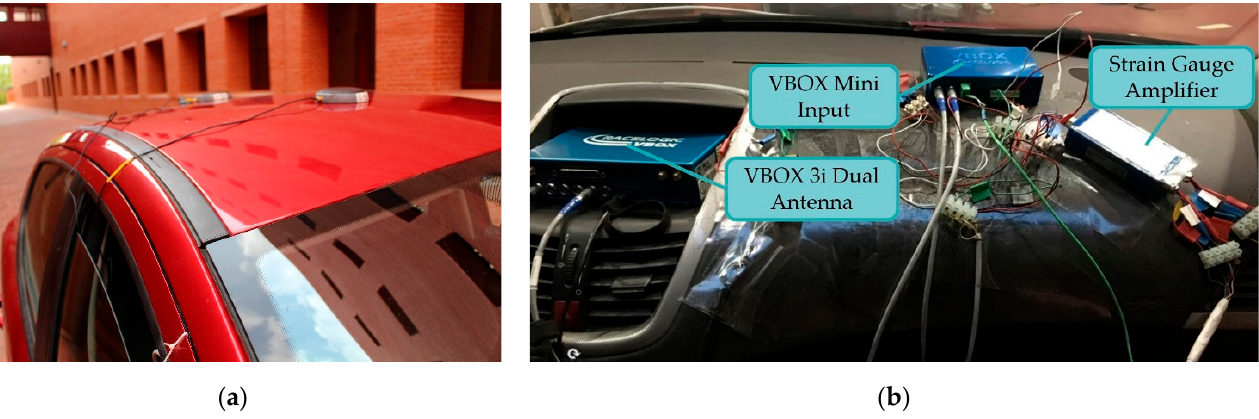
Figure 4. ( a ) Twin antennas located longitudinally on the roof of the vehicle and ( b ) vehicle dashboard data acquisition equipment.